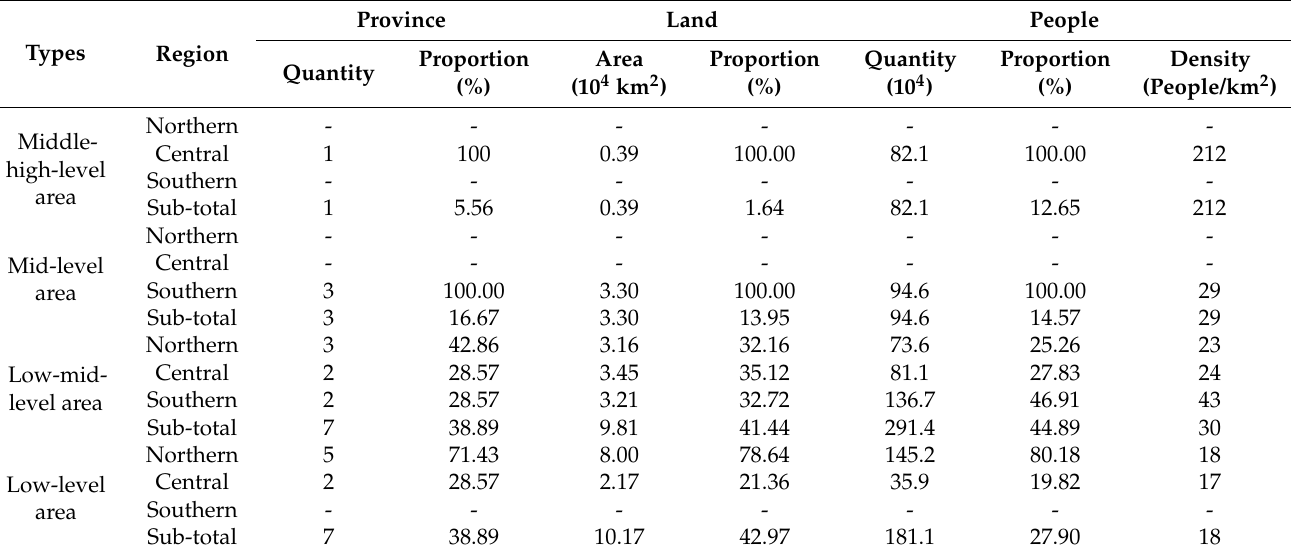
Table 4. Statistics of different socio-economic development levels regions in